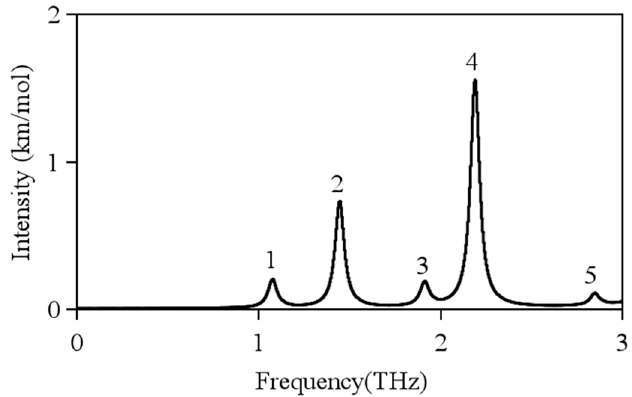
Figure 8. Calculated THz peaks of cellulose in the 0–3 THz frequency range. Lorentzian line shapes convolved into all modes to provide a visual guide.